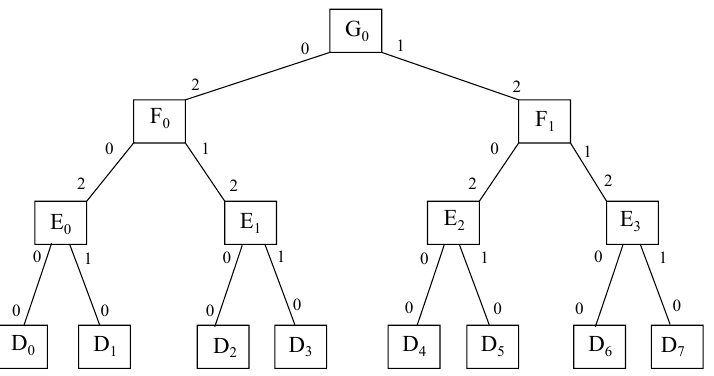
Figure 1. Instance of the arithmetic framework